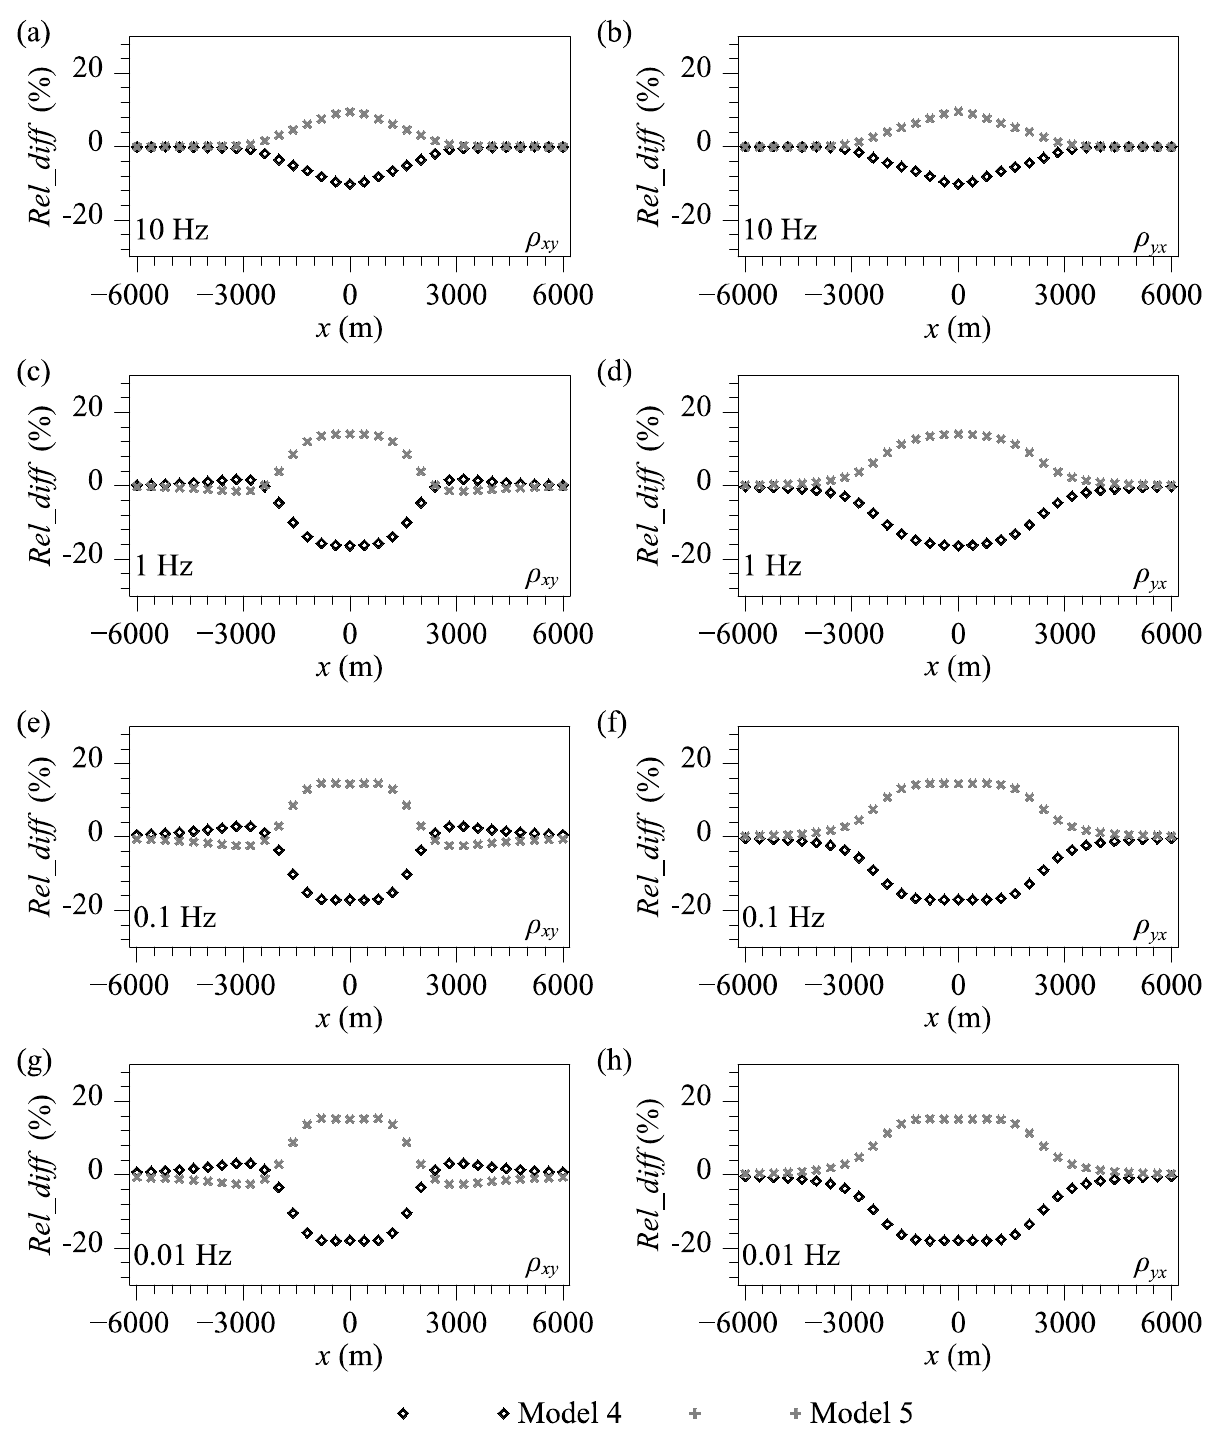
Figure 9. The relative differences between the apparent resistivities of Model 1, and Models 4 and 5. Models 4 and 5 are obtained by perturbing the smectite-layer resistivity of Model 1 by 20% of its value. ( a , b ) are for 10 Hz, ( c , d ) are for 1 Hz; ( e , f ) are for 0.1 Hz, and ( g , h ) are a for 0.01 Hz.